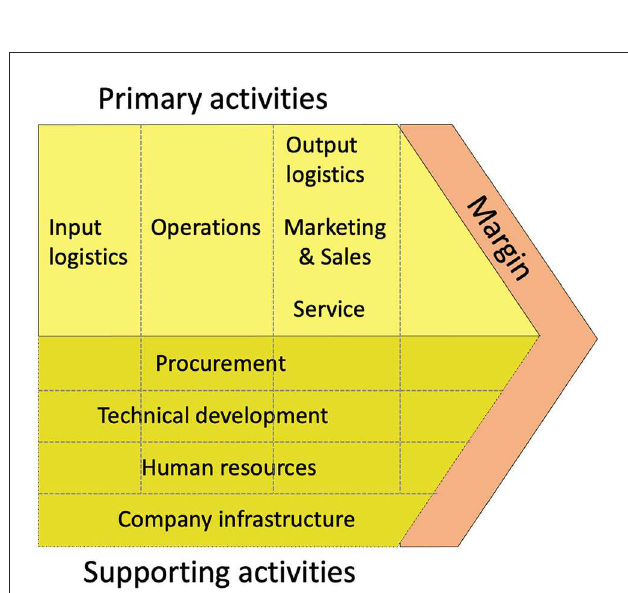
FIGURE3 Value chain of a company [after (Porter, 1991)]; light yellow, upper half: primary company activities; dark yellow, lower half: supporting company activities; orange, leading chevron shape: company margin.